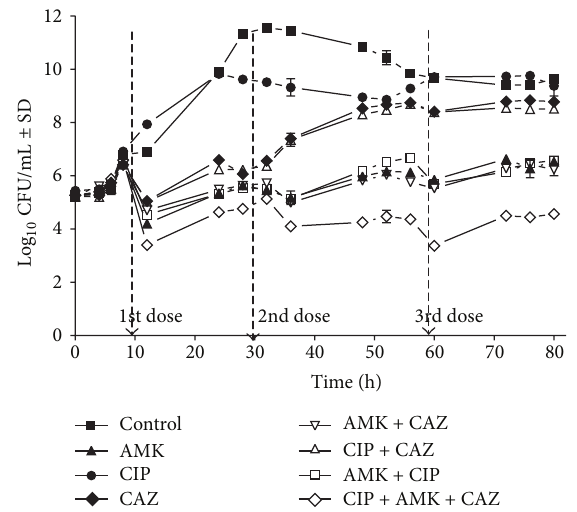
Figure 3: Evaluation of double and triple combinations of cipro- floxacin, amikacin, and ceftazidime against isolate PA14 by time- kill assay in a chemostat model. Isolate PA14 was added at 1 to 5 × 10 5 CFU/mL to bottles containing cation-adjusted Muller Hinton broth. The first doses of the antibiotics, alone or in combination, were added at concentration equivalent to double of their minimum inhibitory concentrations after 10 hours of inoculation. The second and third doses of the antibiotics were added at 30 and 60 hours of incubation. The flow rate was kept at 10mL/h throughout the experiment. AMK, amikacin; CIP, ciprofloxacin; CAZ, ceftazidime.